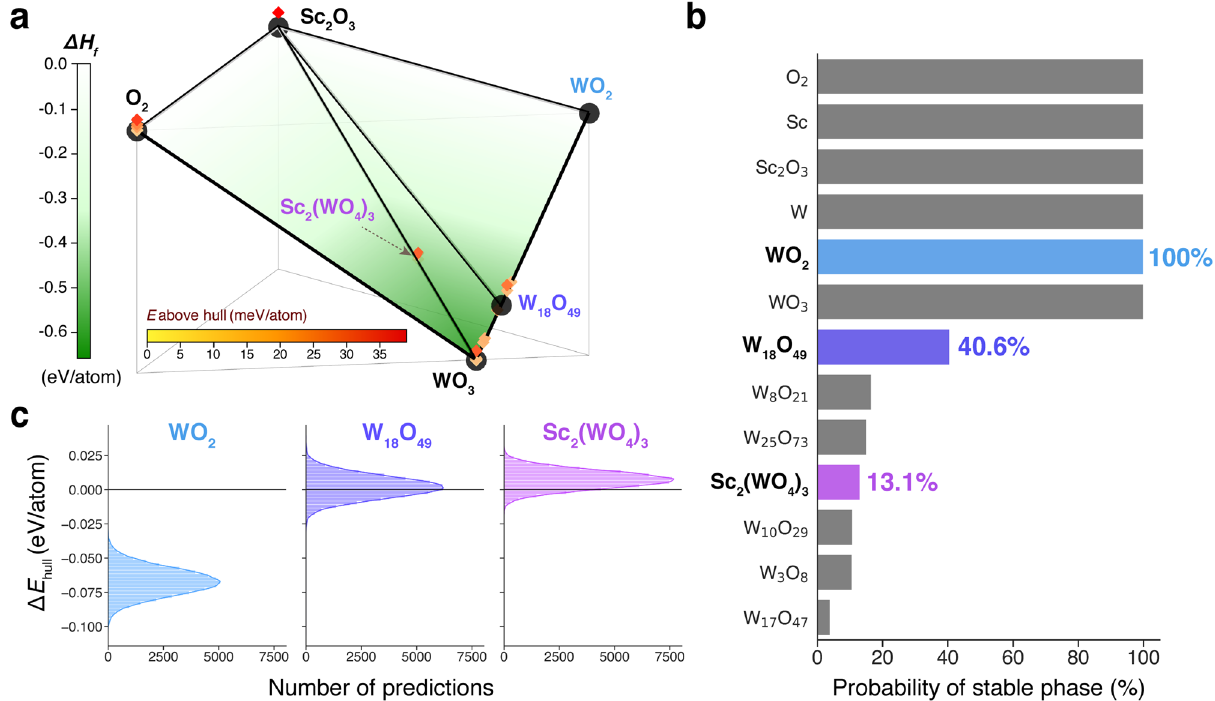
Figure 2. Probabilistic estimation of phase stability enabled by computed DFT energy uncertainties. ( a ) Side- view of compositional ternary phase diagram for the Sc 2 O 3 –WO 2 –O 2 system indicating phases predicted to be stable (black circles) by DFT without considering uncertainty. Formation enthalpy, (cid:31) H f , is denoted by the vertical axis and green shading. Unstable entries, i.e., those with a positive energy above hull, are marked as diamonds and accordingly shaded by energy above hull. ( b ) Probability that each composition in the phase diagram is stable (on the hull) as computed by a bootstrapping method that randomly samples the corrected DFT energy distributions. ( c ) Distribution of the energy to hull ( (cid:31) E hull ) for three selected compositions after 50,000 simulations. WO 2 and W 18 O 49 are predicted to be stable by DFT without considering uncertainty. Sc 2 (WO 4 ) 3 is predicted to be narrowly unstable by previous DFT calculations, but is known to be experimentally